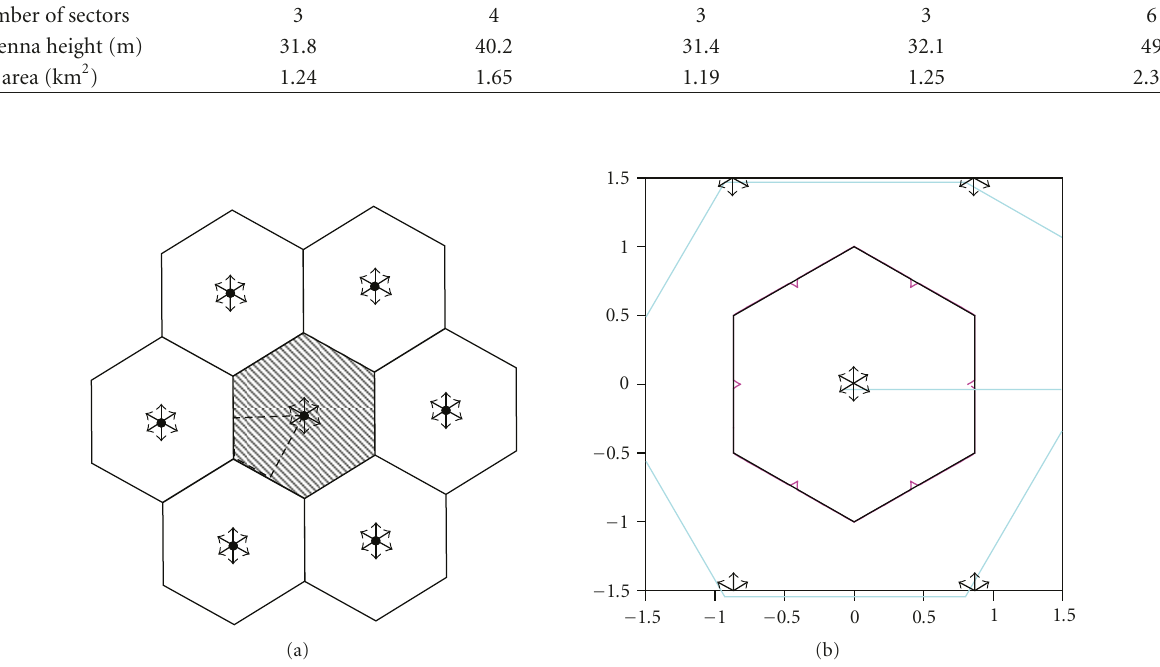
Figure 10: (a) 6-sector hexagon layout and (b) dominance